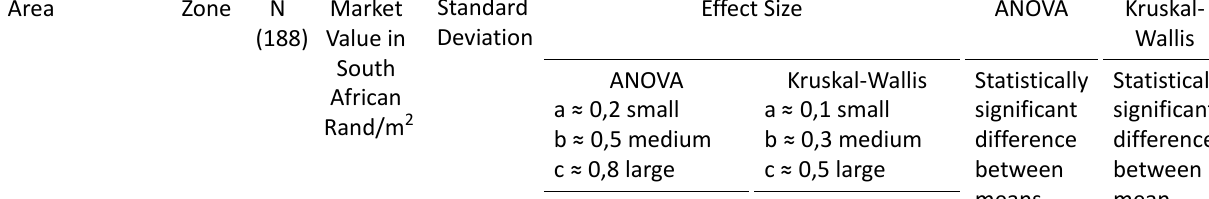
Table 4. ANOVA and Kruskal‐Wallis